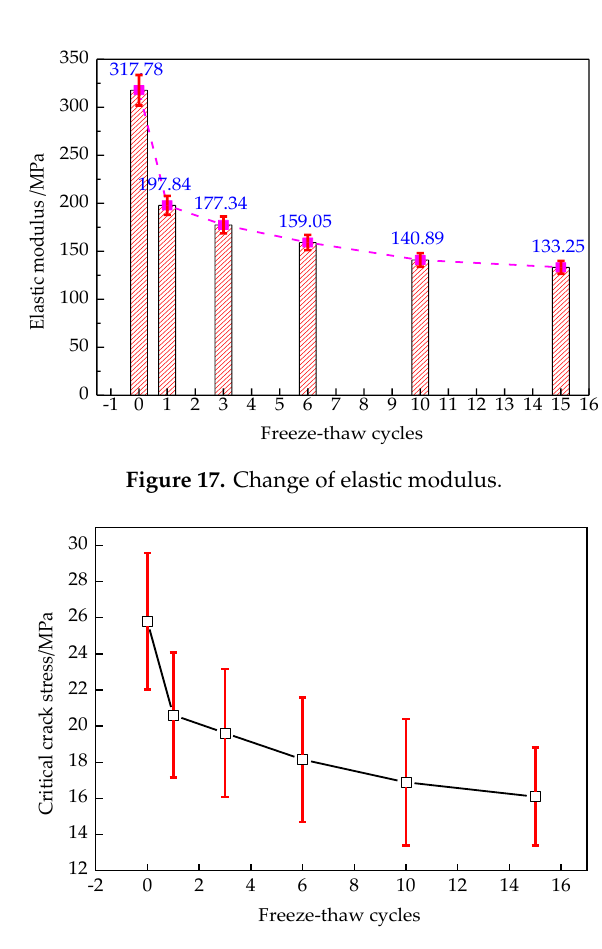
Figure 18. Change of critical crack length with freeze-thaw cycles.